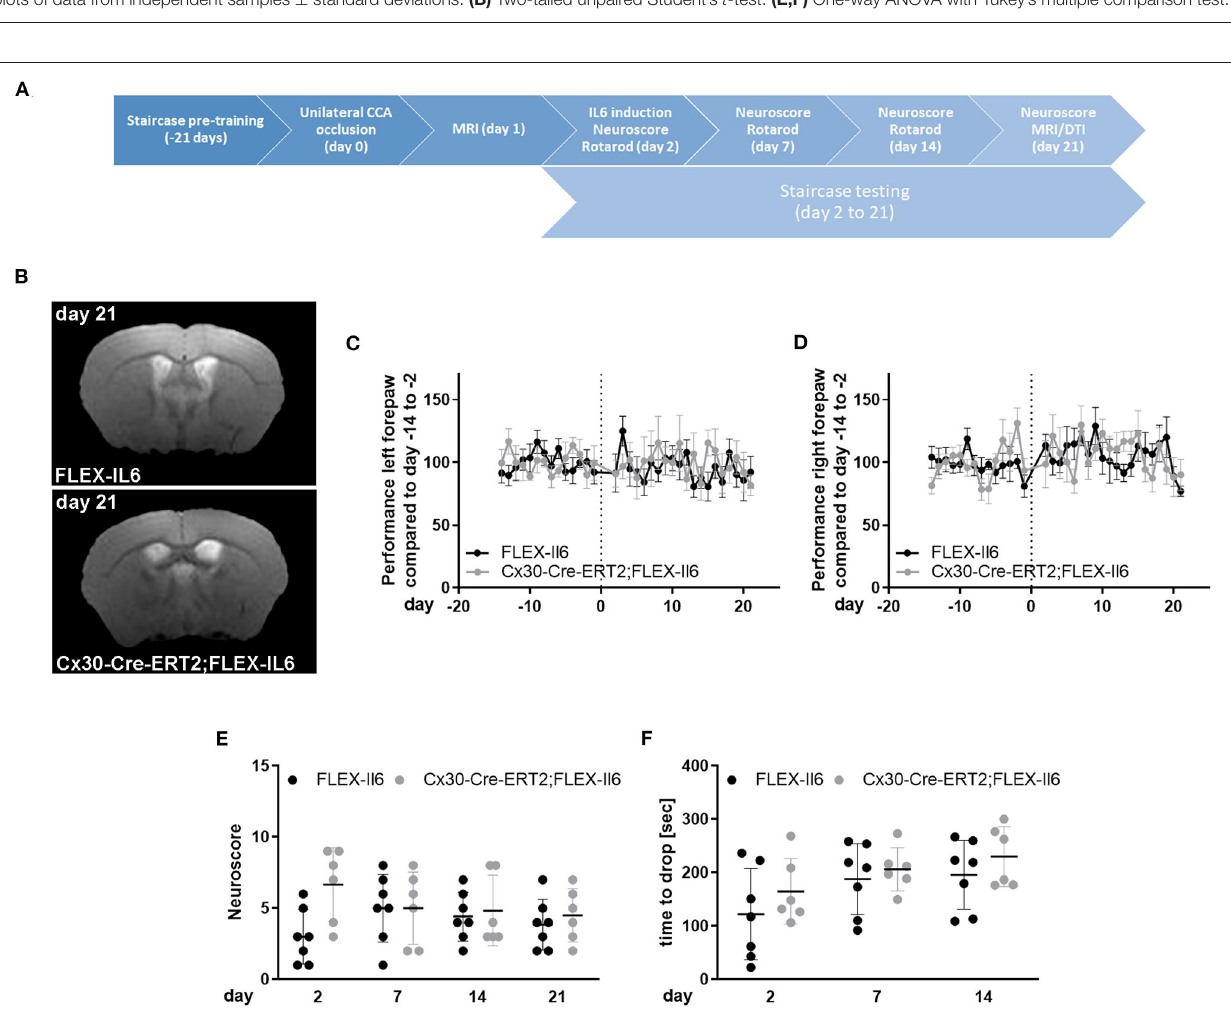
FIGURE 2 | Paracrine IL-6 does not worsen functional outcome or induce strokes after unilateral asymptomatic CCA occlusion. (A) Time-scale: 8 Cx30-Cre-ERT2;FLEX-IL6 and 7 FLEX-IL6 mice were pre-trained in the staircase test for 21 days. On day 0, mice received a left-sided unilateral CCA occlusion and an MRI on day 1 after surgery. One Cx30-Cre-ERT2;FLEX-IL6 and one FLEX-IL6 was excluded due to developing a stroke immediately after surgery. On day 2 after surgery, paracrine IL6 was induced by a single tamoxifen administration. Motor function was evaluated on day 2, day 7, and 14 with the Rotarod test and day 21 with the DeSimoni Neuroscore. Forepaw function was evaluated daily with the staircase test from day 2 to day 21. (B) T2-weighted MRI scans showed no ischemic lesion or white matter damage 21 days after unilateral carotid occlusion in both genotypes. (C,D) Staircase test for the left (C) and right (D) forepaw. The performance was normalized to the individual performance before surgery. No change in performance was observed compared to the performance before surgery and between genotypes. (E) Overall sickness and neurological status were determined by DeSimoni Neuroscore. Cx30-Cre-ERT2;FLEX-IL6 mice ( n = 6) showed a transient increase in sickness behavior immediately after IL6 induction, which reached no significance compared to FLEX-IL6 control mice ( n = 7). (F) Gross motor performance was evaluated using the RotaRod test. After the intervention, the average time to drop on the moving Rotarod increases over time in the experimental and the control group. There is no significant difference between groups. Graphs show scatter dot plots of data from individual mice ± standard deviations. (C–F) Two-way ANOVA with Sidak’s multiple comparison test.